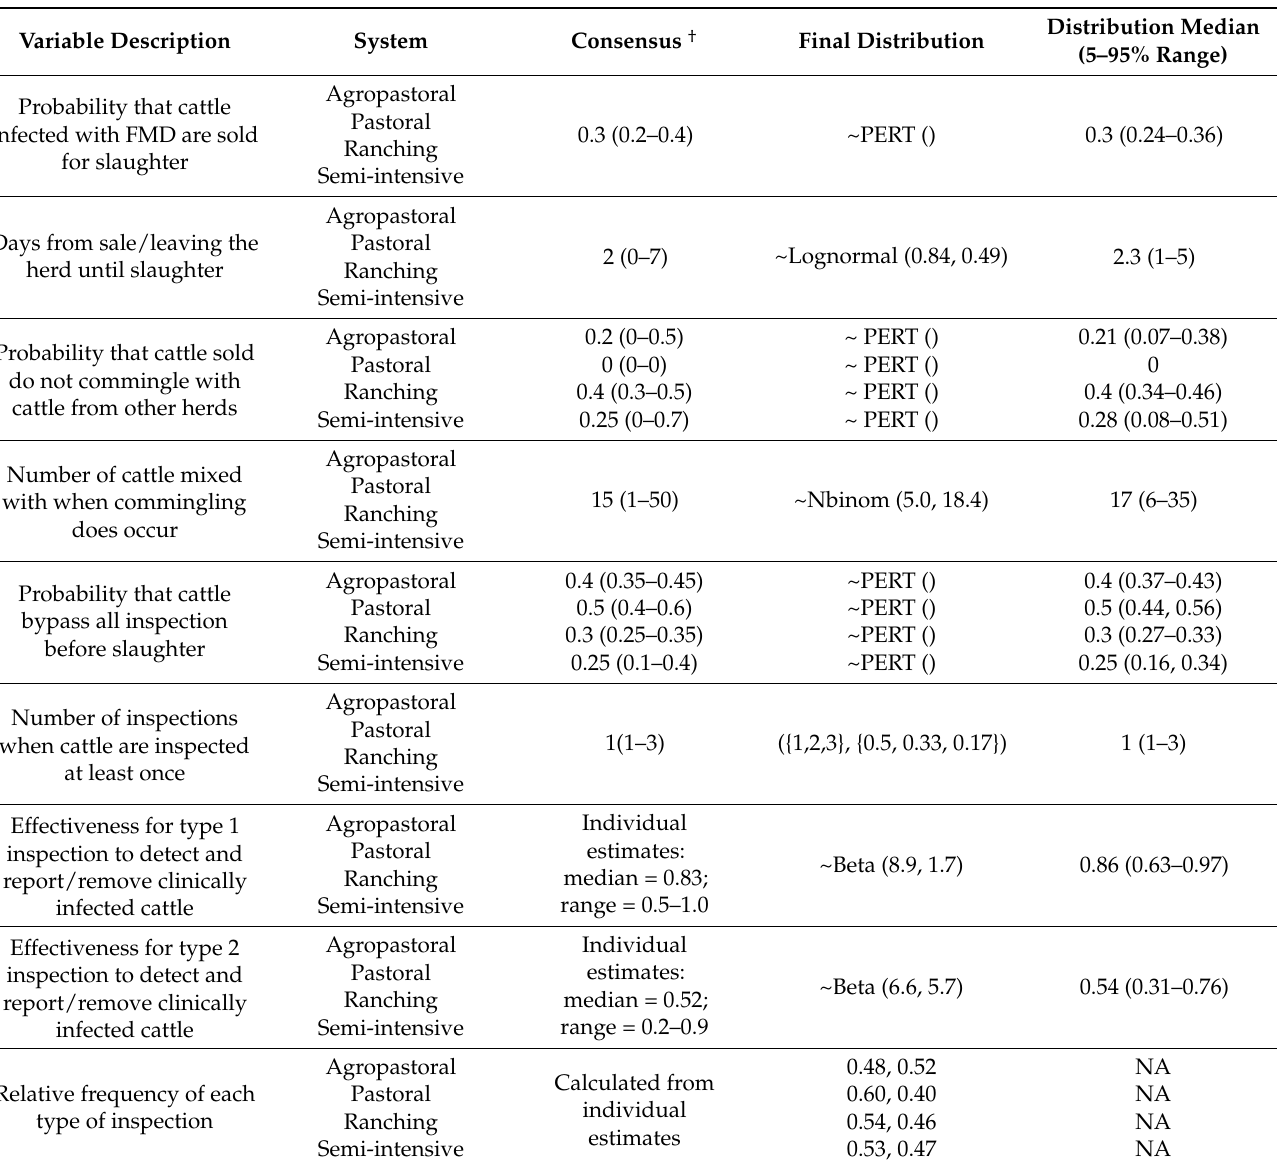
Table A2. Group consensus and final distribution for each variable for cattle production systems in